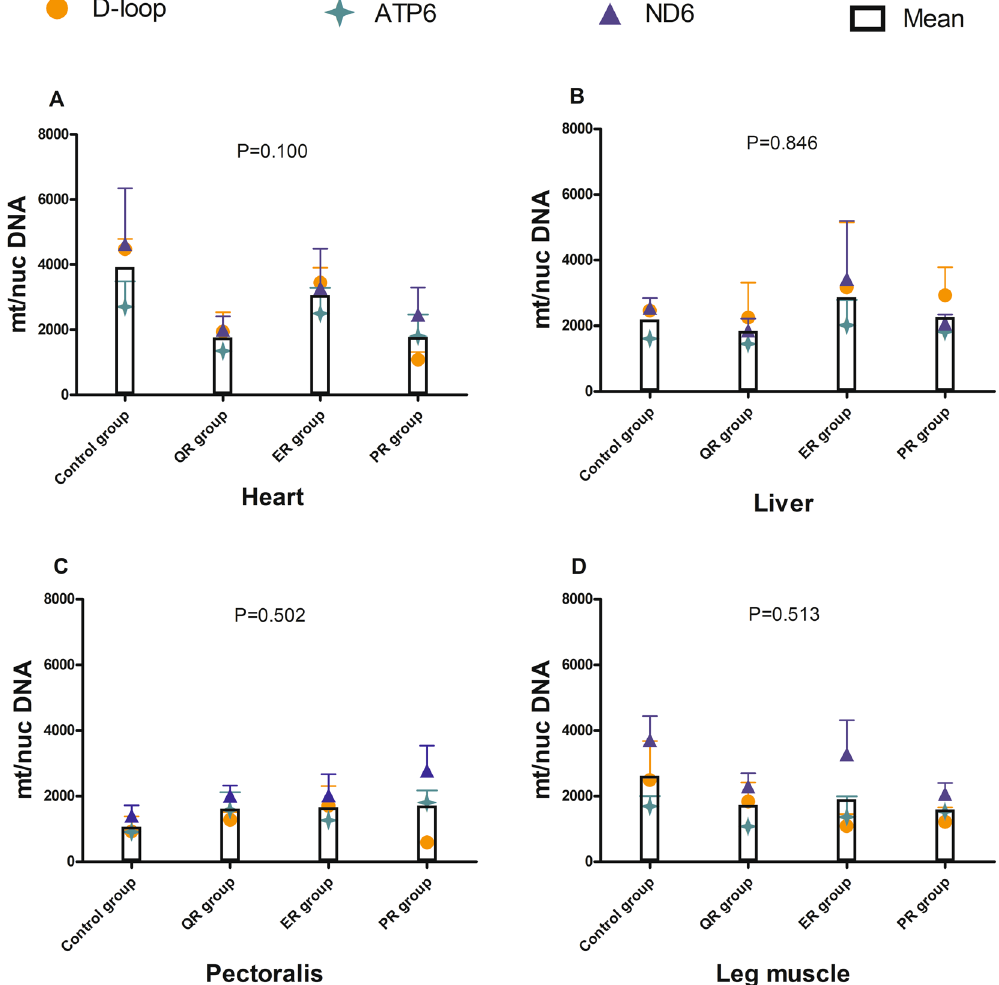
Figure 5. Effects of feed restriction on the mtDNA copy number of 21 d broilers in different tissues. ( A ) Heart; ( B ) liver; ( C ) pectoralis; ( D ) leg muscle. P group = 0.229; mt/nucDNA = mtDNA relative to nuclear DNA ( GCG ) copy number. P group × tissue = 0.453. The control group was fed a conventional diet ad libitum, the QR group was fed a conventional diet between 8:00–13:00 from 8–21 d, the ER group was fed a 15% energy-restricted diet ad libitum from 8–21 d, and the PR group was fed a 15% protein-limited diet ad libitum from 8–21 d. n =